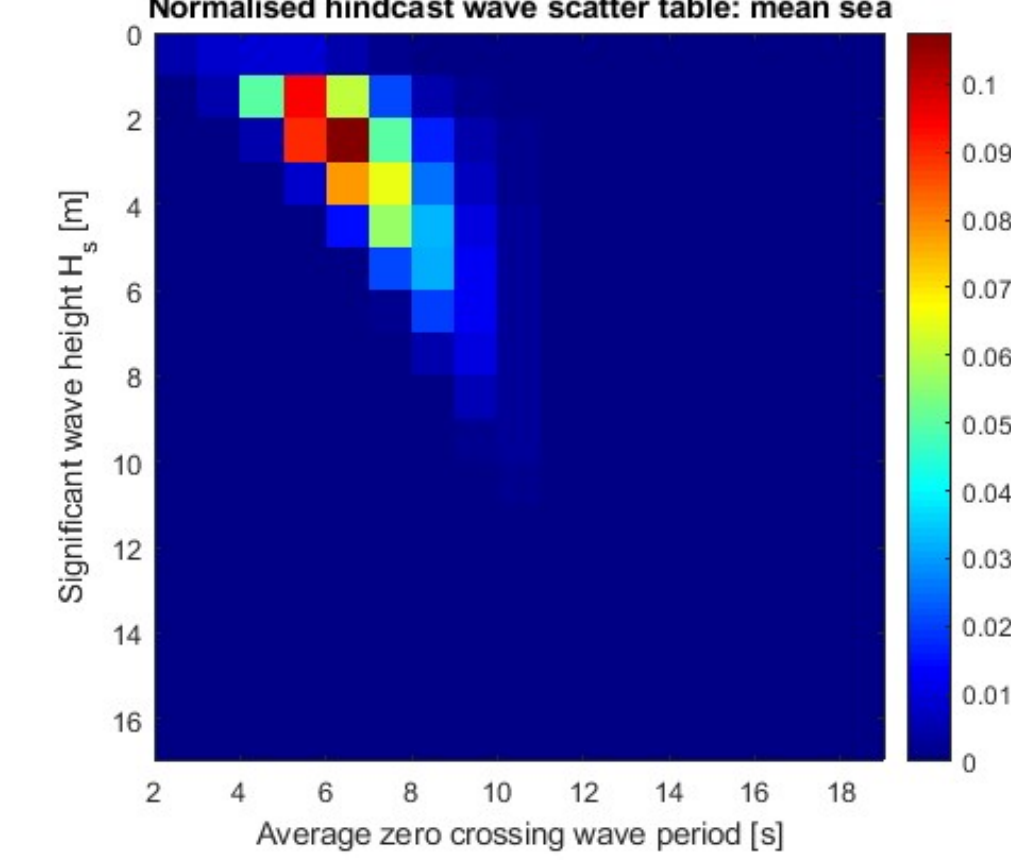
Figure 5. Hindcast WST for wind sea (sea area S—full year).